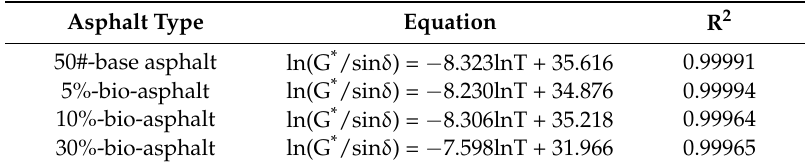
Table 3. Linear fitting results of different asphalt temperature sweep data for the RTFO-aged asphalt. Asphalt